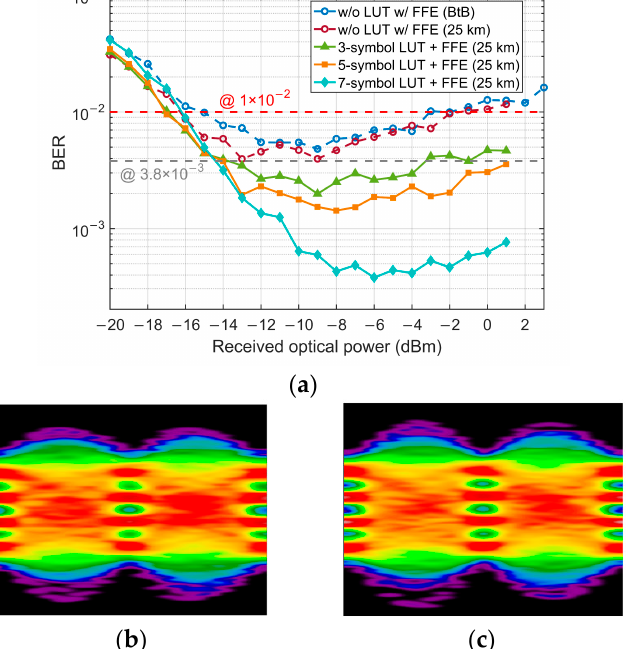
Figure 7. ( a ) BER of post FFE combined with several LUTs. Eye diagrams with 3- ( b ) and 5-symbol ( c ) LUT pre-compensation and FFE at − 3 dBm ROP.